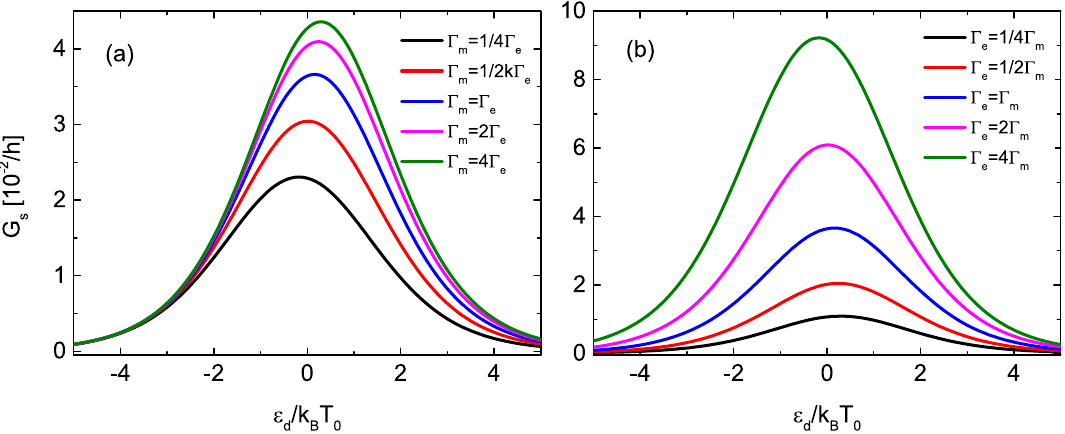
Figure 3. Spin conductance for asymmetric couplings in the limit of U of the dot’s level position calculated for indicated values of ( a ) coupling strengths to magnonic reservoir with 0.1 k Ŵ e B T 0 ( b ) coupling strengths to electronic reservoir with Ŵ m = = 0.1 g µ B B k B T 0 , k B T k B T 0 and k B T 0 = = =